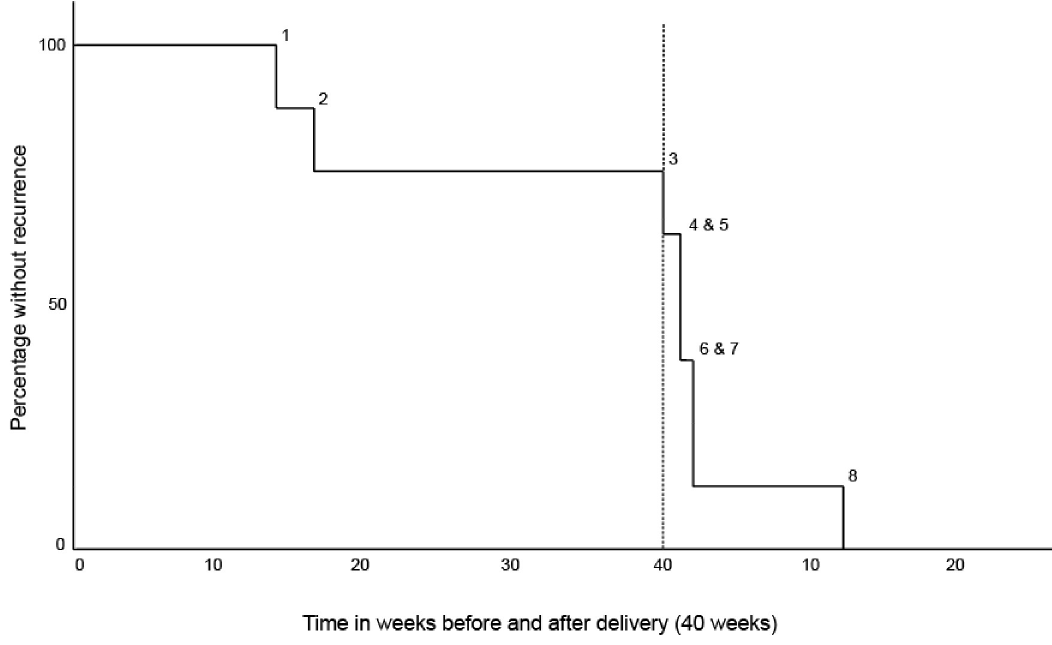
Fig 2. Survival curve of women with recurrence of depression in the perinatal period. Numbers in figure represent separate cases and match with case numbers listed in Table 2.